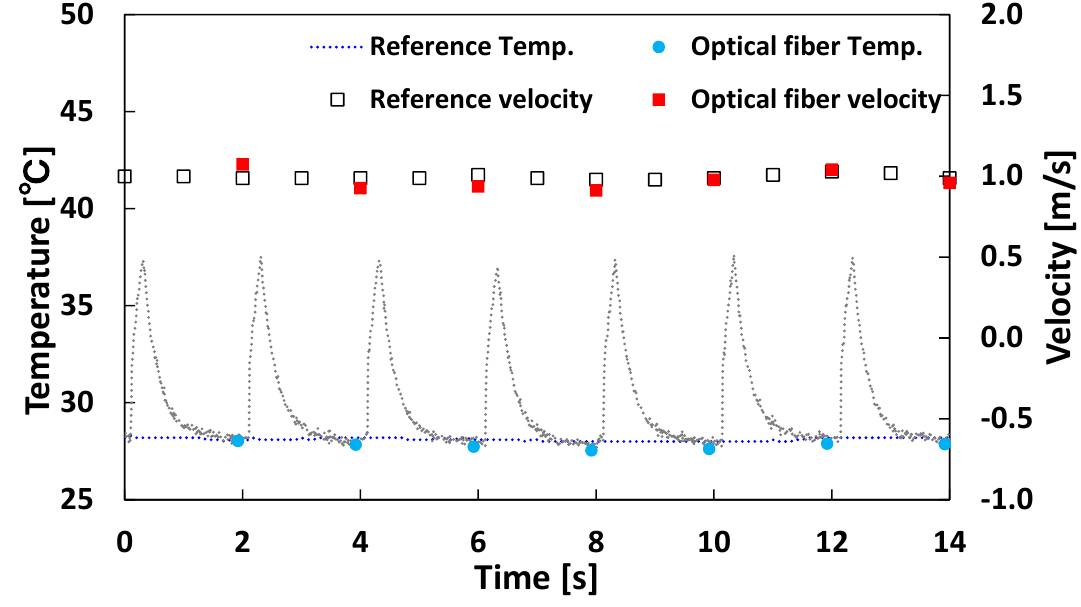
Figure 6. Temperature time series data during temperature and velocity measurements. Table 2. Measurement errors of measuring devices. Device Unit Range Type-K